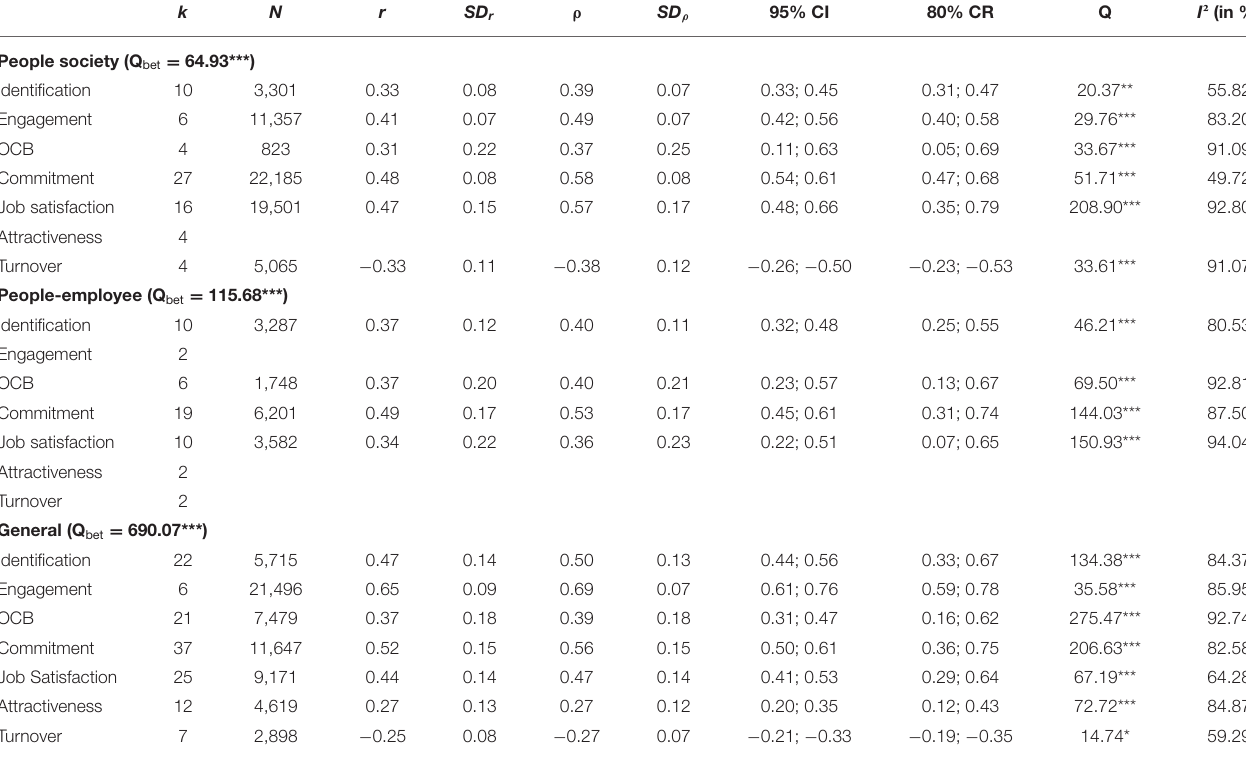
TABLE 5 | Subsample analyses for employee-related attitudes and citizenship behaviors and focus of CSR